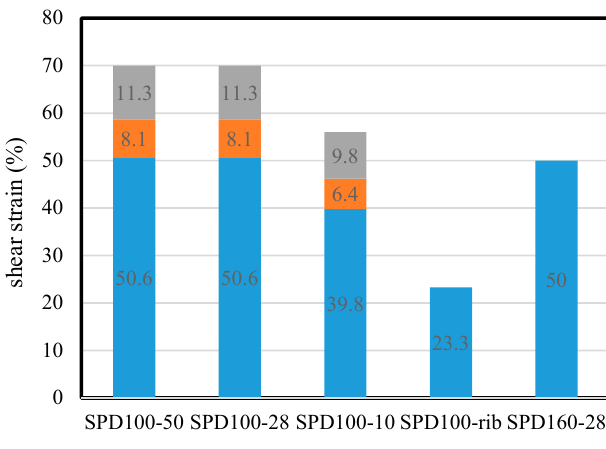
Figure 9. Ductility capacity.